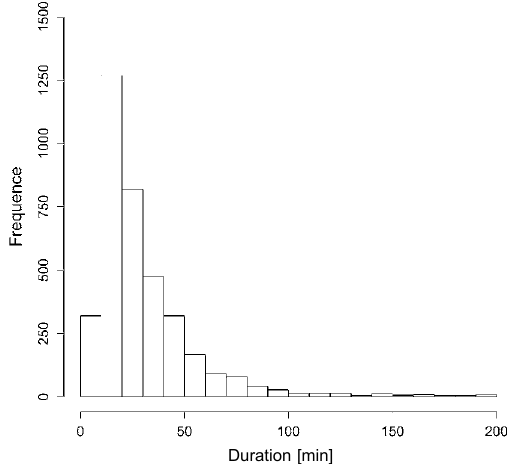
Fig. 1. Distribution of traffic incident